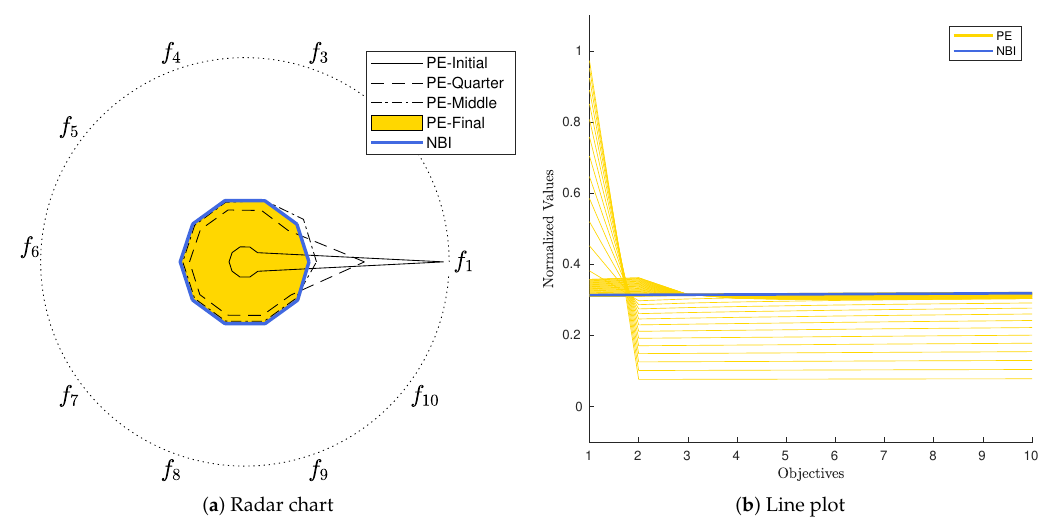
Figure 8. Numerical results for the minDTLZ2 problem for k = 10.